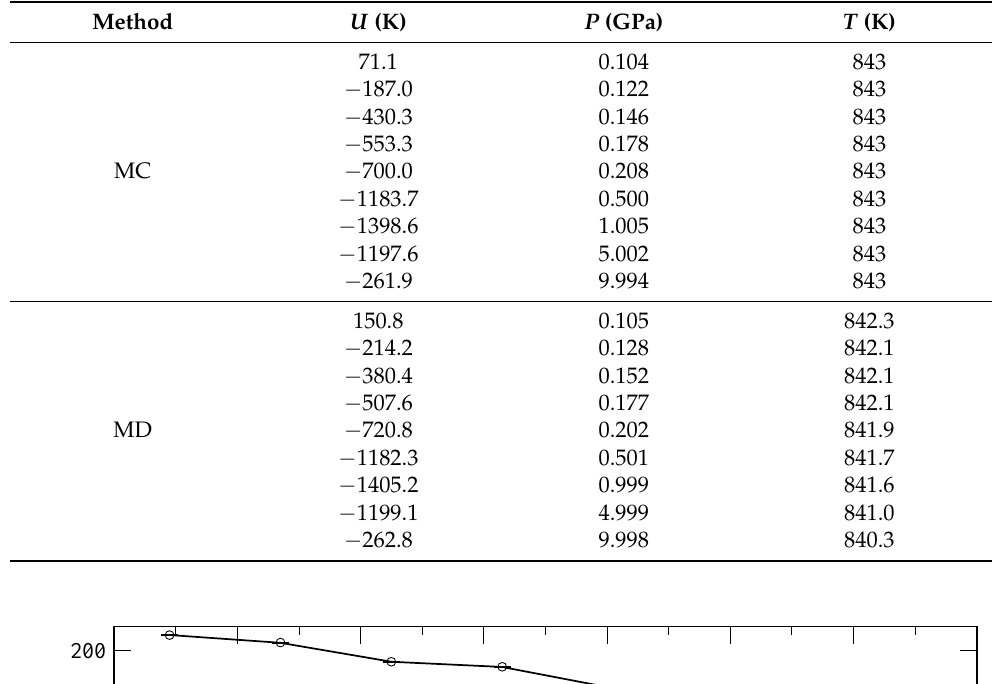
Table 1. Average internal energies ( U ), pressures ( P ) and temperatures ( T ) for the simulated setups. All MC simulations considered 10 8 sampling moves and all MD simulations were of total length 200 ps.